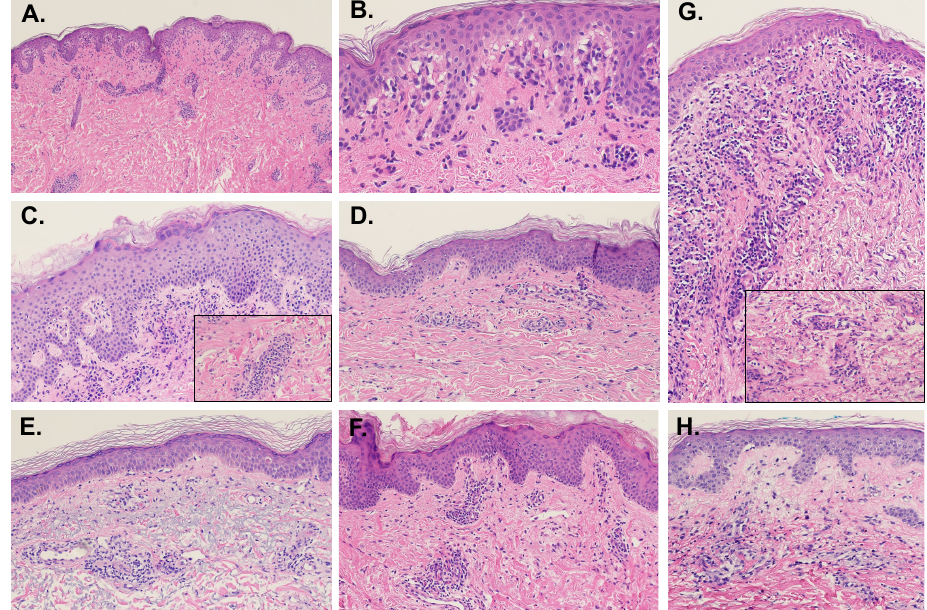
Figure 1. Examples of histopathologic presentations of maculopapular drug eruptions (H&E, 10 × magnification; Insets, 20 × ). ( A ) In this sample, there are interface vacuolar changes above a mild perivascular lymphocytic inflammatory infiltrate. ( B ) Close up of case A: there is evident interface vacuolar alteration with rare dyskeratotic keratinocytes. ( C ) This case presents with more epidermal hyperplasia, mild spongiosis, and perivascular inflammation with eosinophils (inset). ( D ) In this example, there is mild spongiosis, subtle and focal interface changes and mild perivascular inflammation with eosinophils. ( E ) Interface vacuolar changes can be focal, with rare dyskeratotic ker- atinocytes, and perivascular inflammation. ( F ) This case shows mild epidermal hyperplasia with mild spongiosis, subtle interface changes and mild perivascular inflammation with eosinophils. ( G ) The inflammatory infiltrate with eosinophils (inset) can be more prominent, with interface changes and mild epidermal hyperplasia. ( H ) Mild spongiosis and focal interface and perivascular inflammation with sparse eosinophils characterize this